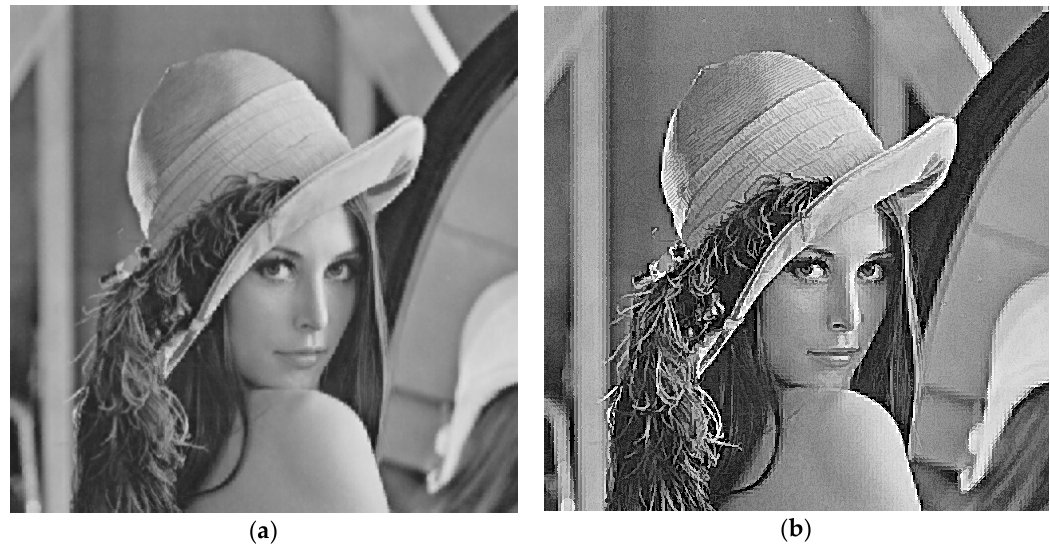
Figure 13. The reconstructed image for block truncation coding (BTC) ( m = 4, r av = 8 bits/block, and r σ = 8 bits/block) with ( a ) an optimal binary quantizer ( y 2 = 1/ 2 ) and ( b ) a non-optimal binary quantizer ( y 2 = 3).